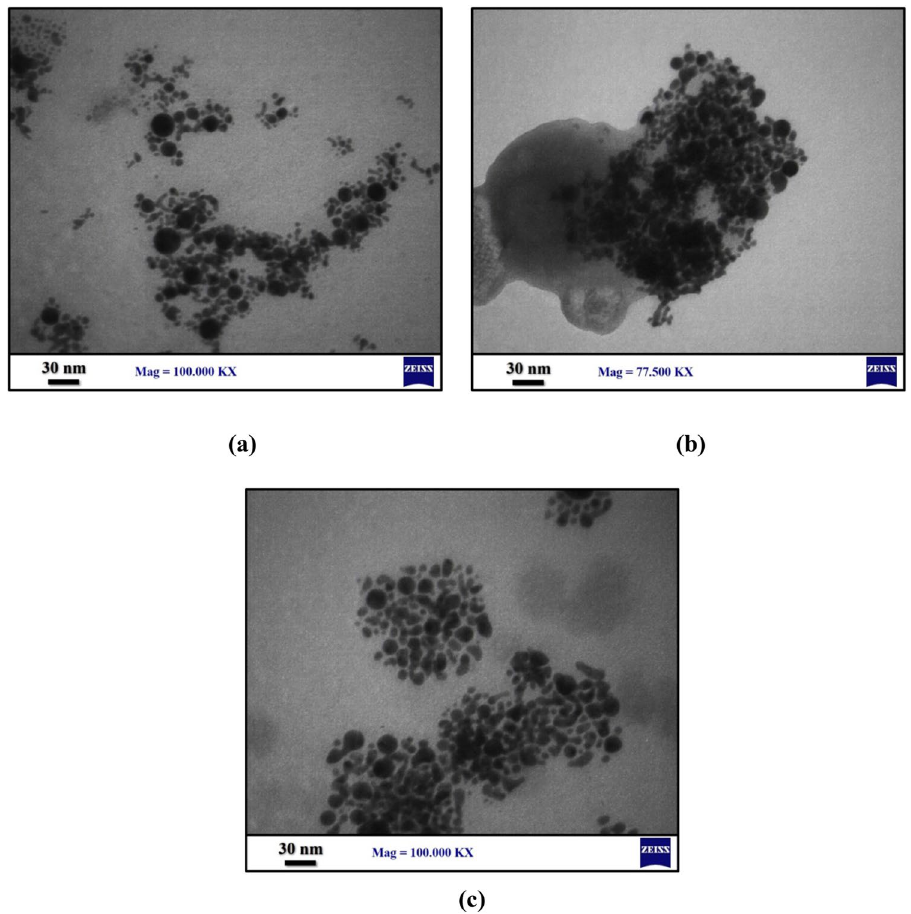
Figure 6. TEM of Au NPs at ablated wavelength of 532 nm and at ablated energy of ( a ) 1000 mJ, ( b ) 1400 mJ and ( c ) 1800